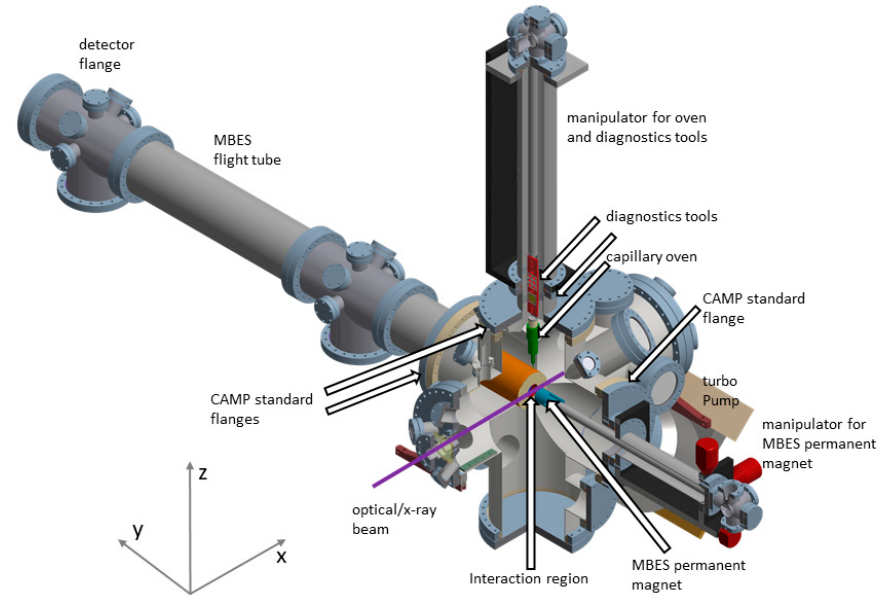
Figure 2. Design-drawing of the URSA-PQ (German for ‘Ultraschnelle Röntgenspektroskopie zur Abfrage der Photoenergiekonversion an Quantensystemen’, Engl. ‘ultrafast X-ray spectroscopy for probing photoenergy conversion in quantum systems’) instrument. The central body contains flanges that adhere to the standard defined by the CAMP-chamber in size as well as distance to the interaction region (marked). The capillary oven and diagnostic tools are mounted on a manipulator allowing for insertion of either device into the beam. The permanent magnet of the magnetic bottle electron spectrometer (MBES) sits on another manipulator to optimally overlap the region of highest sensitivity of the MBES with the interaction region of the optical and X-ray pulses. The 1.7 m long flight tube connects the main body to the detector flange housing the microchannel plate electron detector.